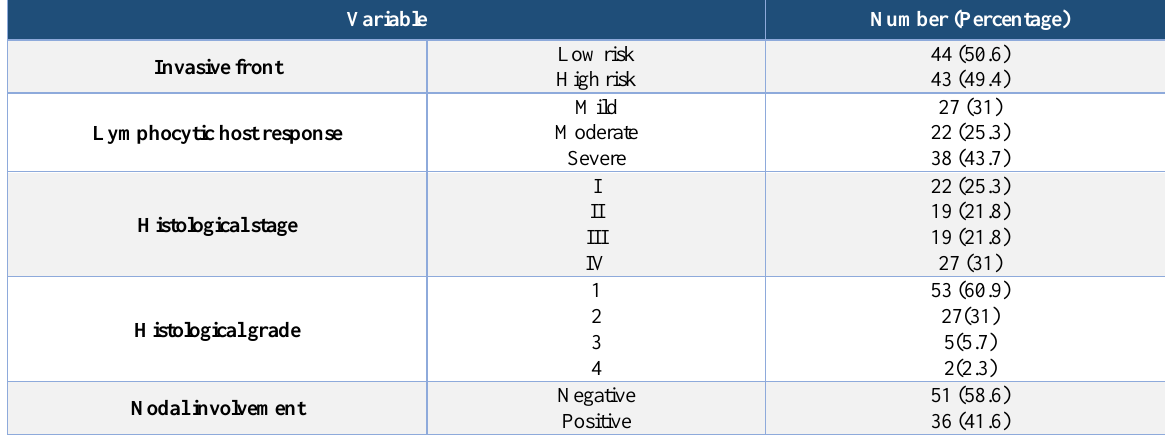
Fig. 1 . A: Low risk IF in early stage and Grade 1 SCC (Arrows) X100, B: High risk IF in advanced stage and Grade III (ARROWS) X100, C: High risk IF in advanced stage and Grade II(ARROWS) X40 Table 1. Clinicopathological parameters of studied